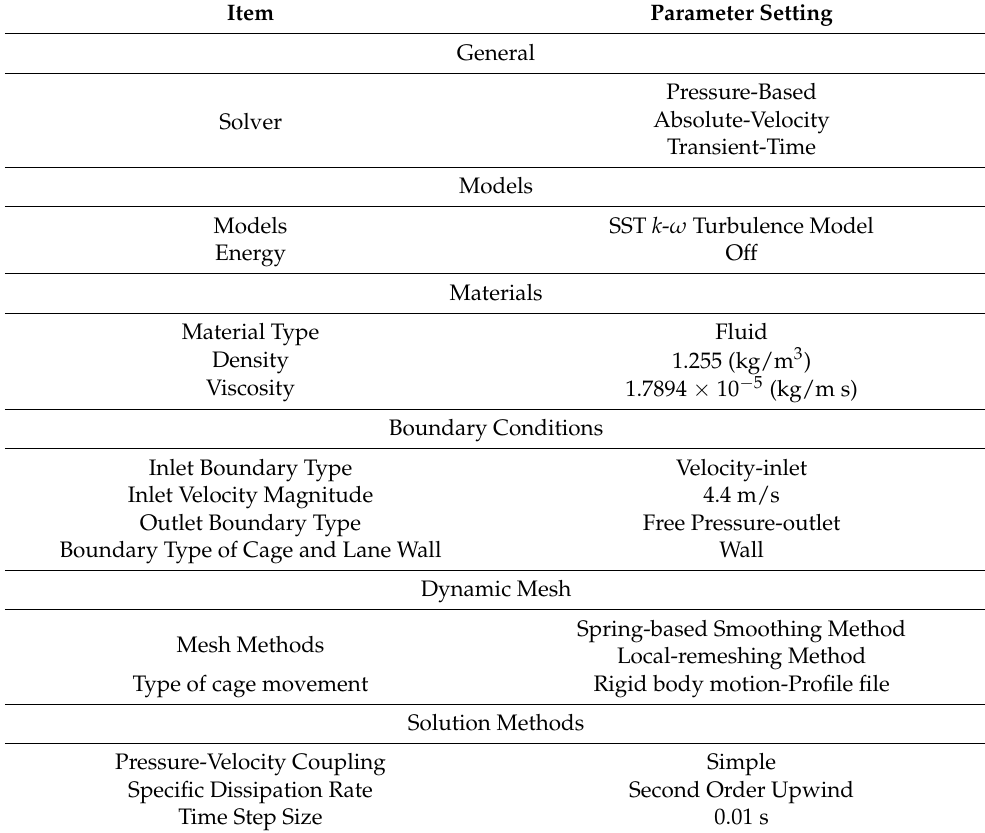
Table 2. Calculation model parameter